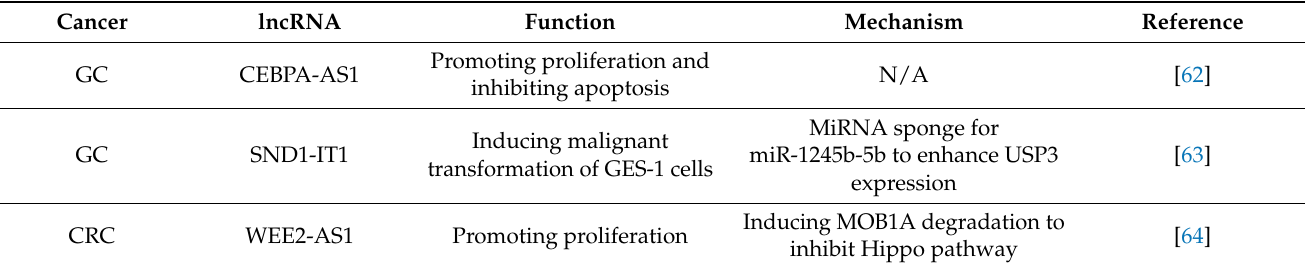
Figure 3. The biological role of exosomal lncRNAs in gastrointestinal cancer. Exosomal lncRNAs are involved in the various processes of gastrointestinal cancer including tumor growth, metastasis, angiogenesis, stemness, immune microenvironment, and drug resistance. Table 1. The function and mechanism of exosomal lncRNAs in gastrointestinal